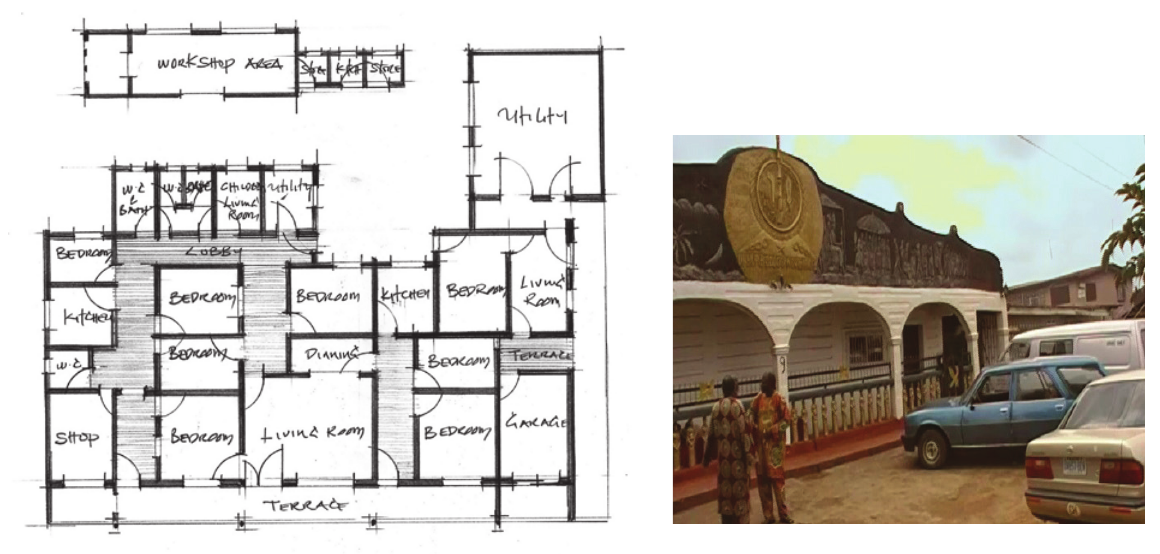
Fig. 6. Floor plan and picture of a typical adapted family-compound Benin house Source: Ekhaese